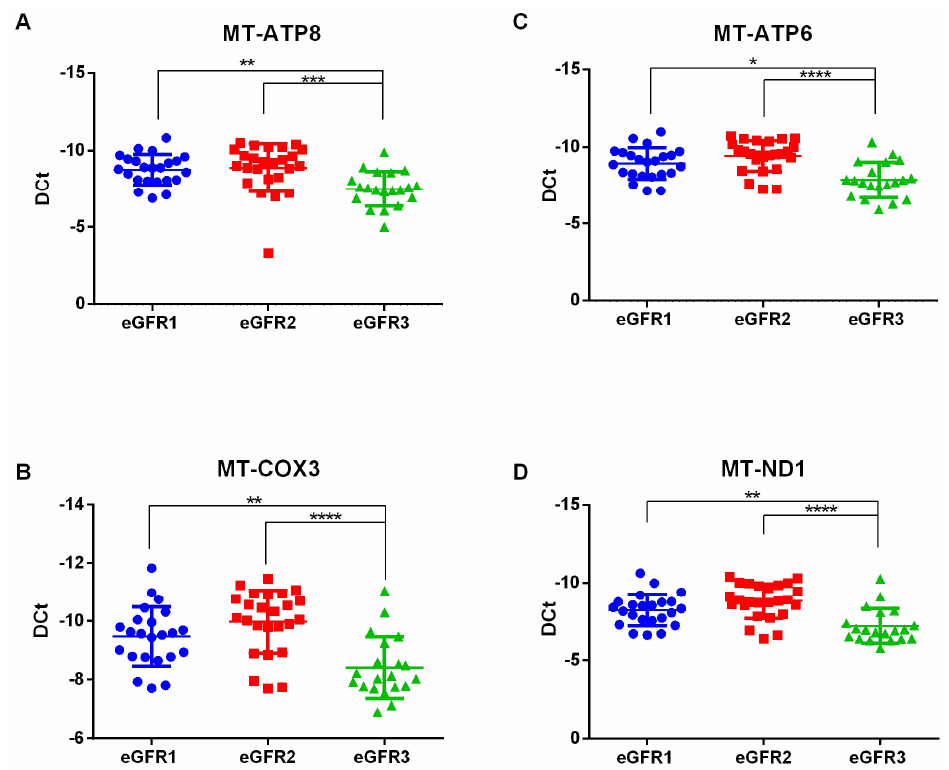
Figure 3. Dot plots of mitochondrial coding RNAs MT-ATP8 (panel A ), MT-ATP6 (panel B ), MT- COX3 (panel C ) and MT-ND1 (panel D ), validated through qPCR in serum samples of diabetic patients with increasing eGFR stages G1, G2 and G3. The Kruskal Wallis test was used for MT-ATP8 which presented a non-parametric distribution. The One-way ANOVA test was used for all the other transcripts showing parametric distributions. n = 69: G1 = 24, G2 = 25, G3 = 20. * p -value < 0.05 ** p -value < 0.01 *** p -value < 0.001 **** p -value < 0.0001.